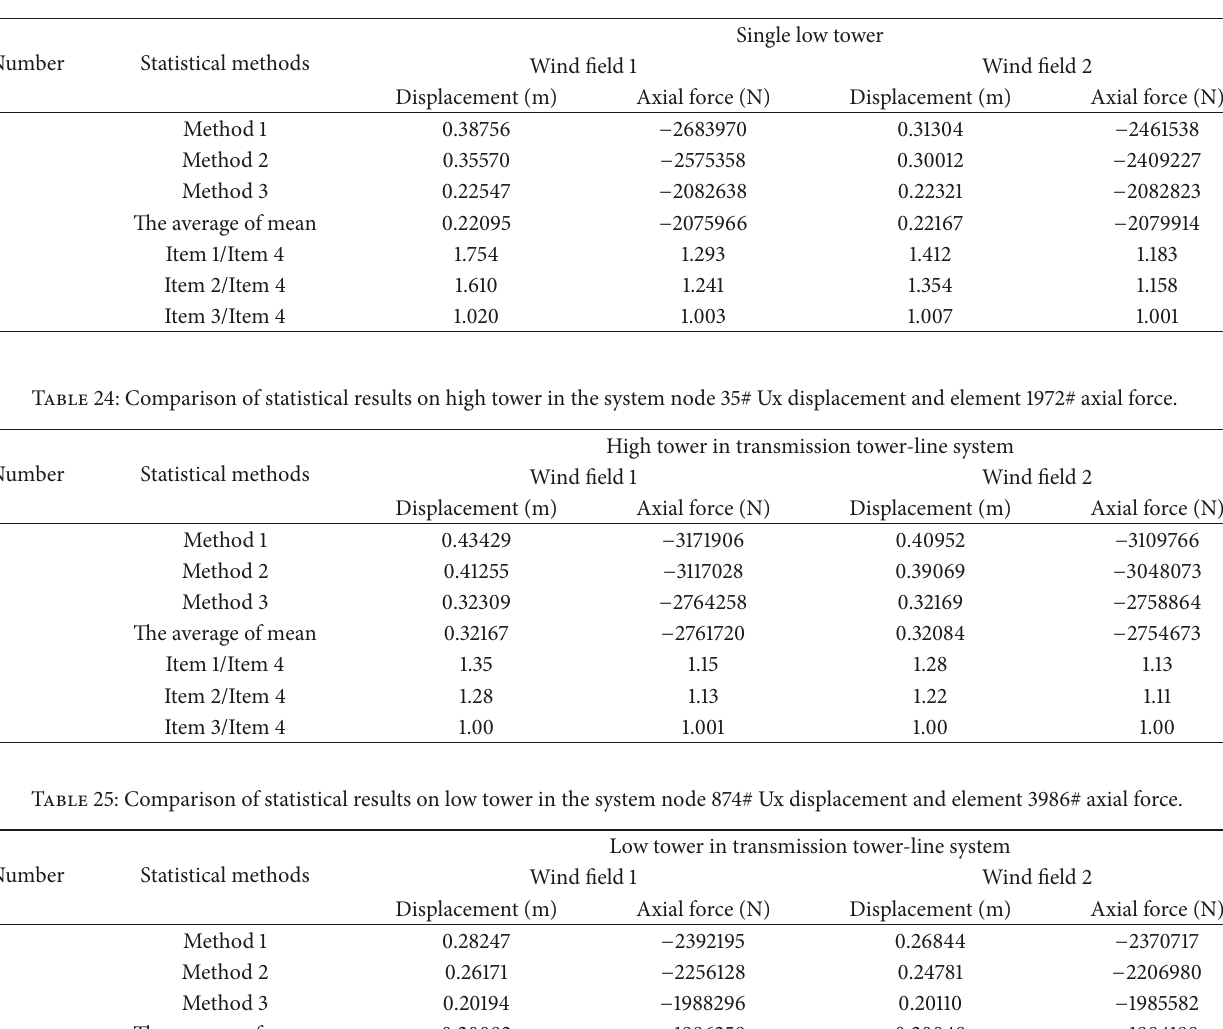
Table 23: Comparison of statistical results on single low tower node 874# Ux displacement and element 3986# axial force.